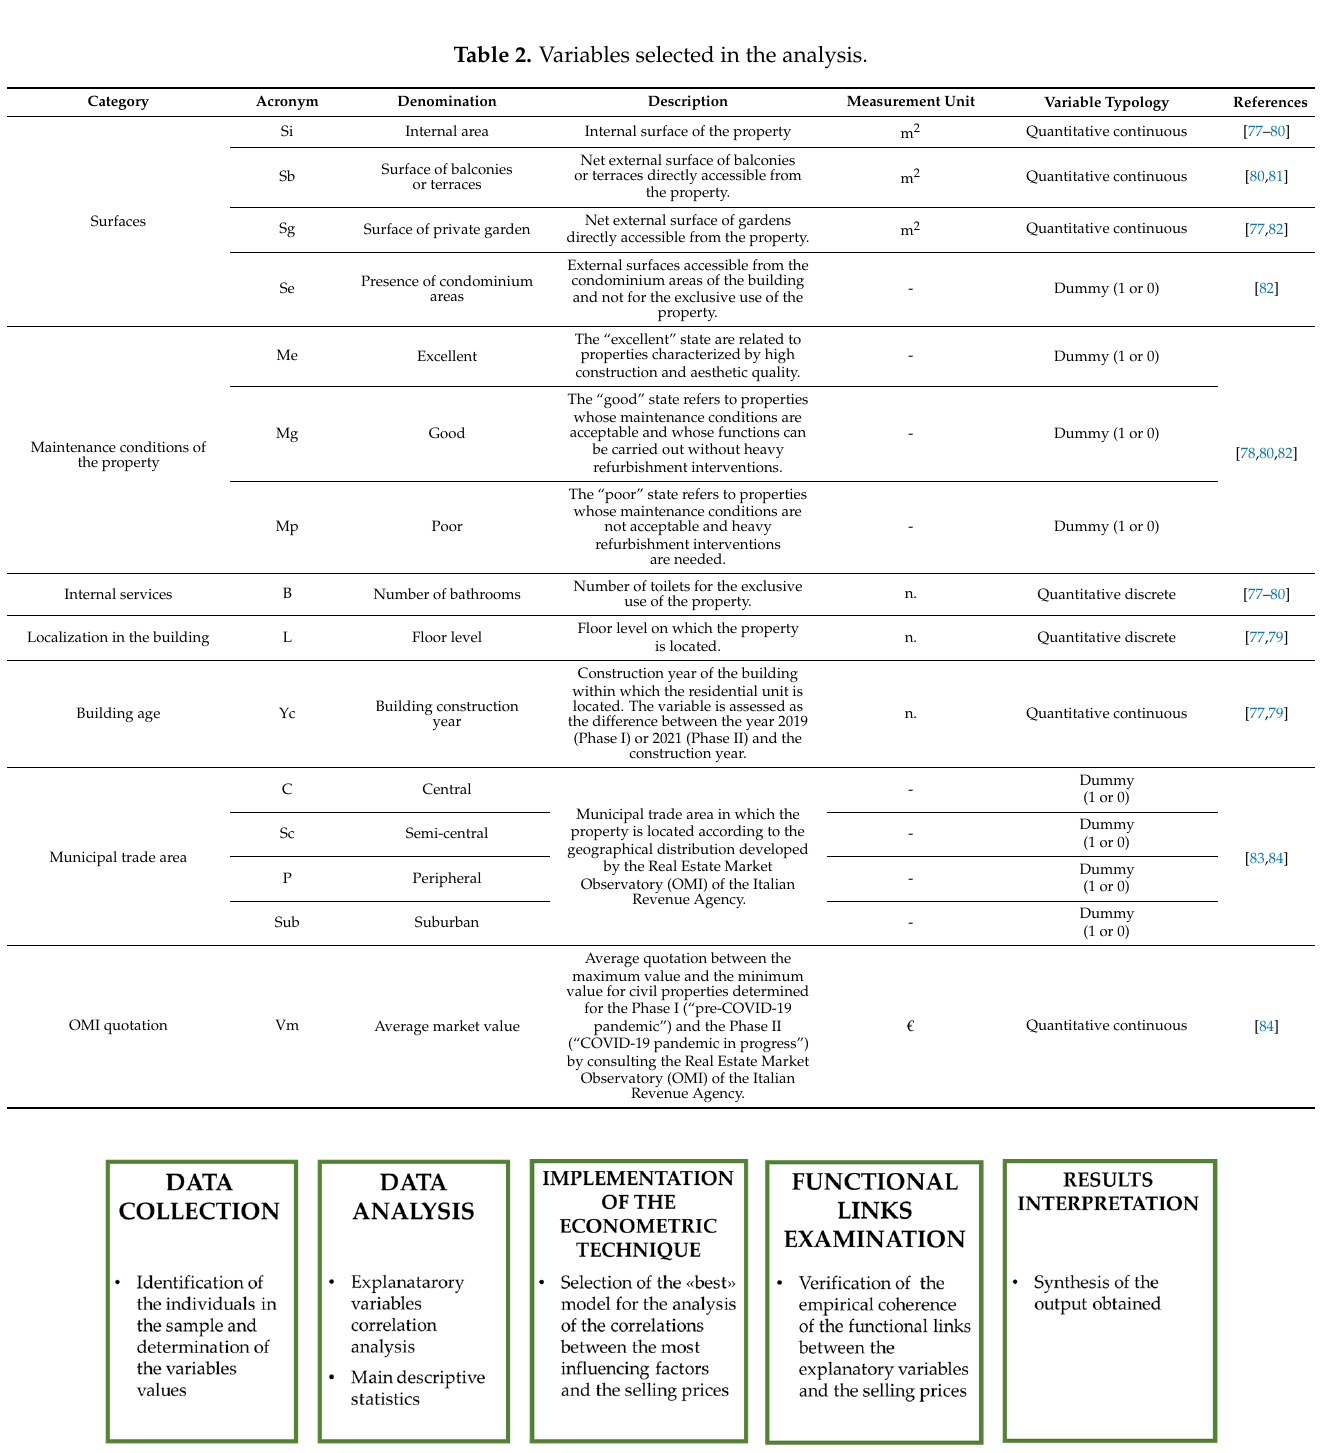
Figure 4. The main operations for the Steps II and III of the methodology application. The data, i.e., the values of the selected explanatory variables relating to each property of the six study samples in both phases, were subsequently homogenized through a normalization operation in order to obtain the numerical terms of the same size order, and to facilitate the comparison between them. Tables S1–S6 in the Supplementary Materials report the main descriptive statistics of the selling prices and values of the explanatory variables for the six Italian cities se- lected and for the two phases analyzed (Phases I and II). The investigation has allowed